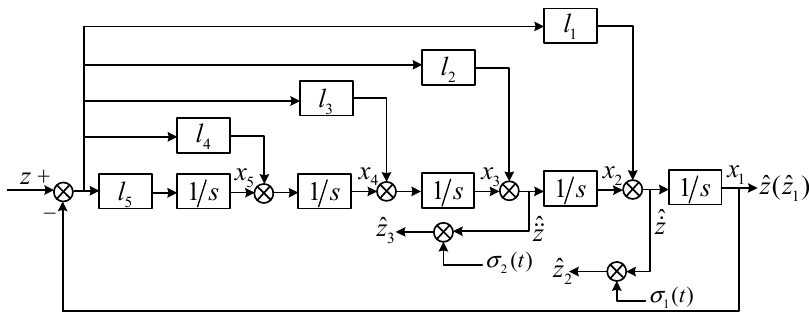
Figure 3. The block diagram of fifth-order high order differentiator (HOD).